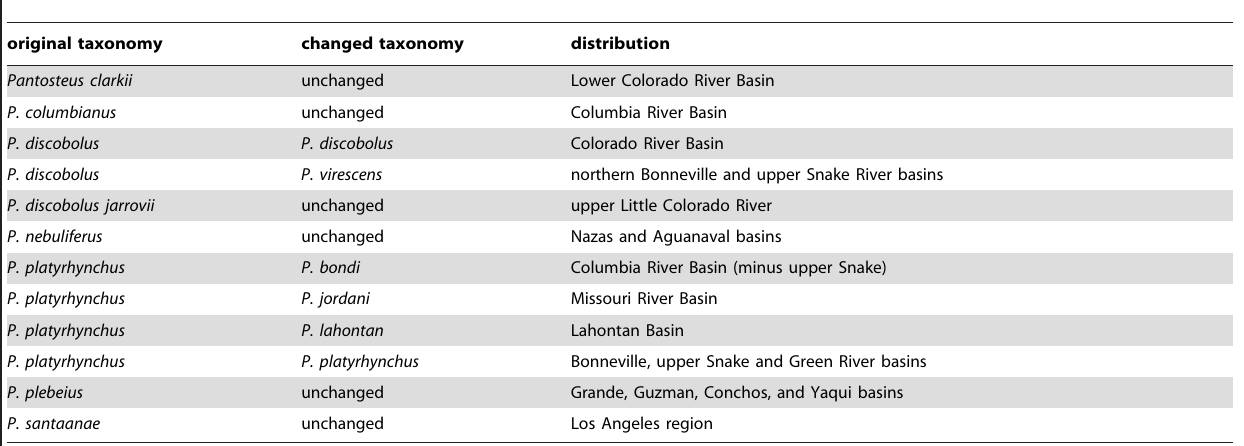
Table 2. Proposed changes to the taxonomy of Pantosteus